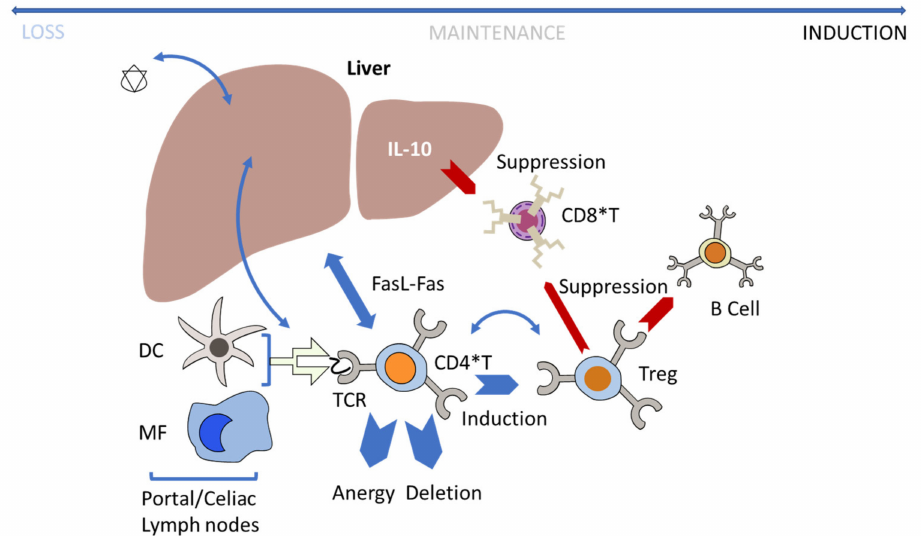
Figure 6. Antigen-specific transgene tolerance. Hepatic gene transfer with adeno-associated virus (AAV) vectors induces tolerance by multiple mechanisms, which include programmed cell death of CD4 + T-helper cells and the induction of FoxP3 + T reg . The initial presentation of antigens to the liver draining portal/celiac lymph nodes and the liver resident antigen-presenting cells (APCs) plays an important role in the induction of liver tolerance. DC, dendritic cell; Fas, Fas cell surface death receptor; FasL, Fas ligand; IL, interleukin; MF, macrophage; TCR, T-cell receptor; Treg, T regulatory